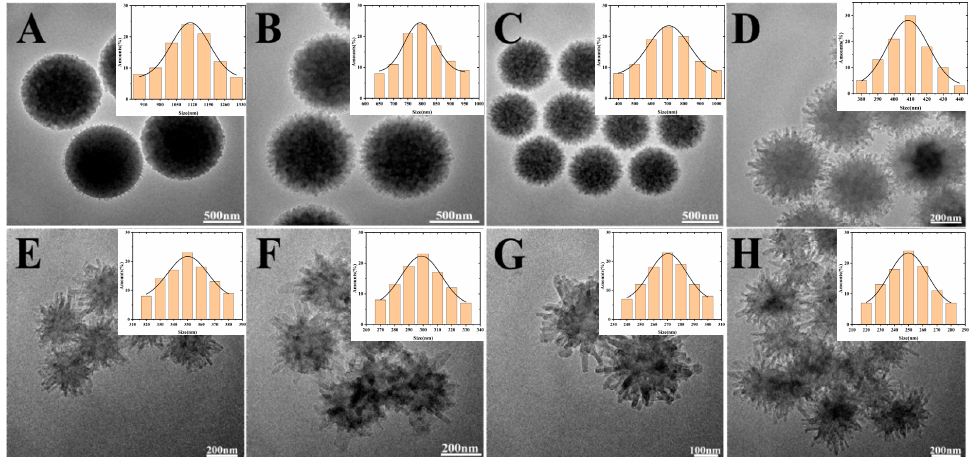
Figure 2. TEM images and particle diameter distribution of uniform spherical COFs nanomaterials with different sizes prepared in 0.2, 0.4, 0.6, 0.8, 1.0, 1.2, 1.4 and 1.6 mL HAc solution: ( A ) 0.2 mL, 1100 nm; ( B ) 0.4 mL, 800 nm; ( C ) 0.6 mL, 700 nm; ( D ) 0.8 mL, 400 nm; ( E ) 1 mL, 350 nm; ( F ) 1.2 mL, 300 nm; ( G ) 1.4 mL. 270 nm; ( H ) 1.6 mL, 250 nm.